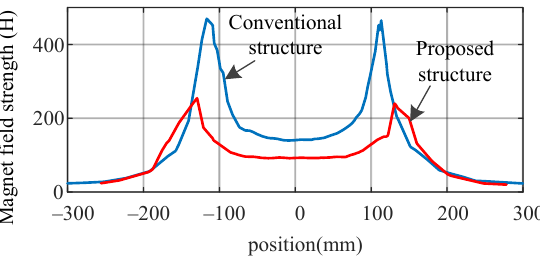
Figure 26. Magnetic field strength curves at 10 mm above the shields. The test line B is located at 10 mm from the profile of the shield and used to obtain